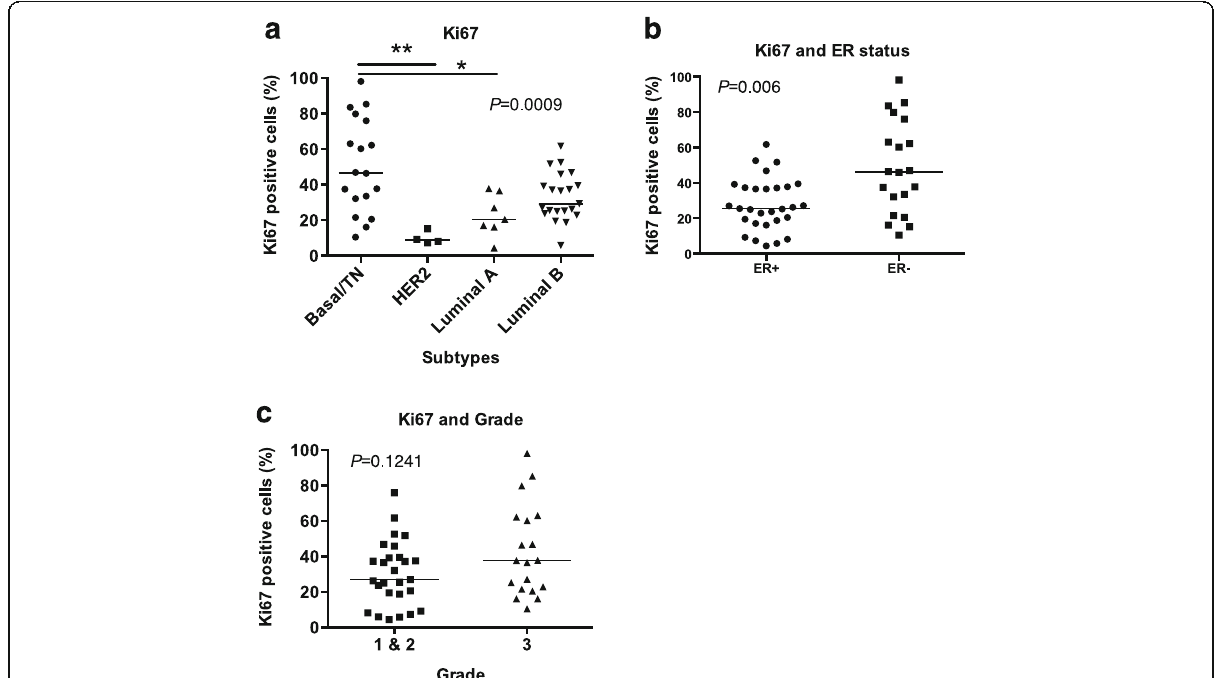
Fig. 1 Ki-67 status in Kenyan breast tumors by molecular subtype and grade. Breast cancer tissue samples were stained for Ki-67 and scored for percent Ki-67-positive cells. Ki-67 status then was compared across molecular subtype ( a ) by Kruskal-Wallis ( P= 0.0009) followed by Dunn ’ s multiple comparison tests, ER status ( b ) by Mann-Whitney ( P = 0.006), and grade ( c ) by Mann-Whitney ( P = 0.1241) (the P value is indicated by * and ** for P < 0.05 and P <0.01,